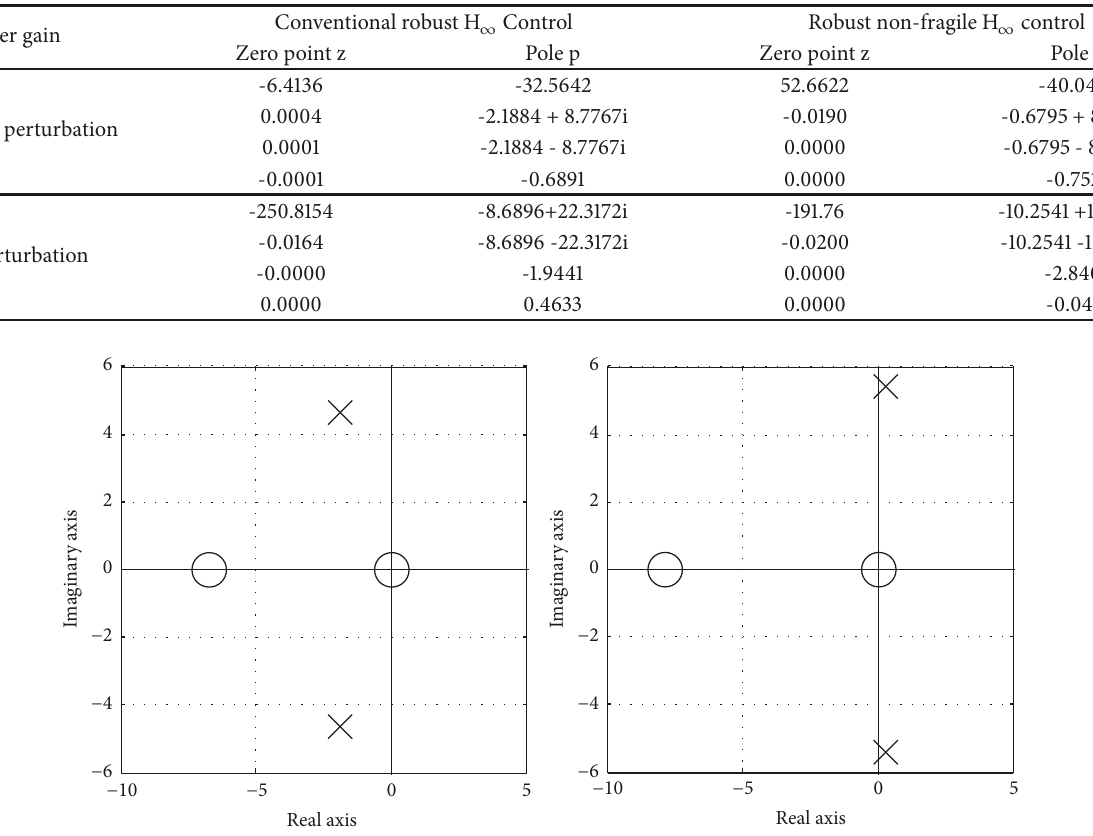
Figure 6: Conventional robust H ∞ control for vehicle body head-shaking acceleration. (a) Without perturbation. (b) With perturbation.